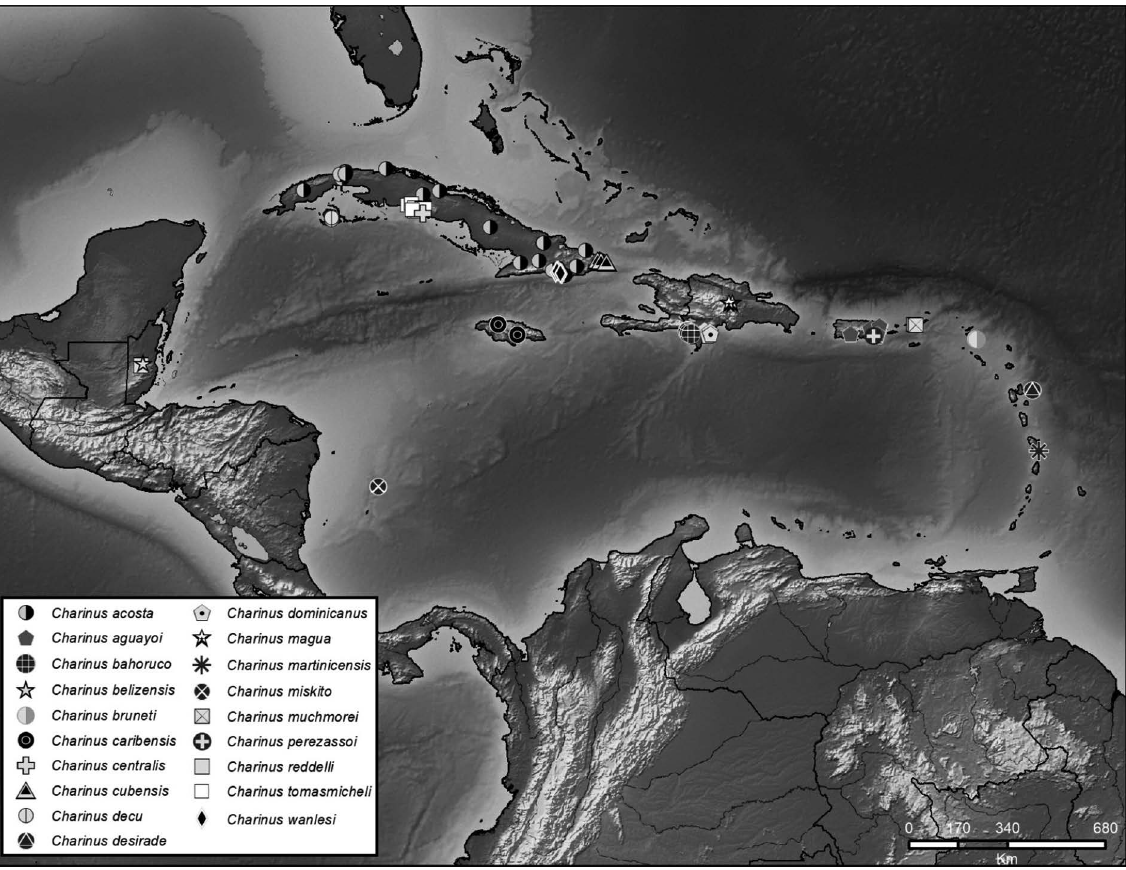
Fig. 12. Map plotting known distributions of species of Charinus Simon, 1892 in the Caribbean and Central